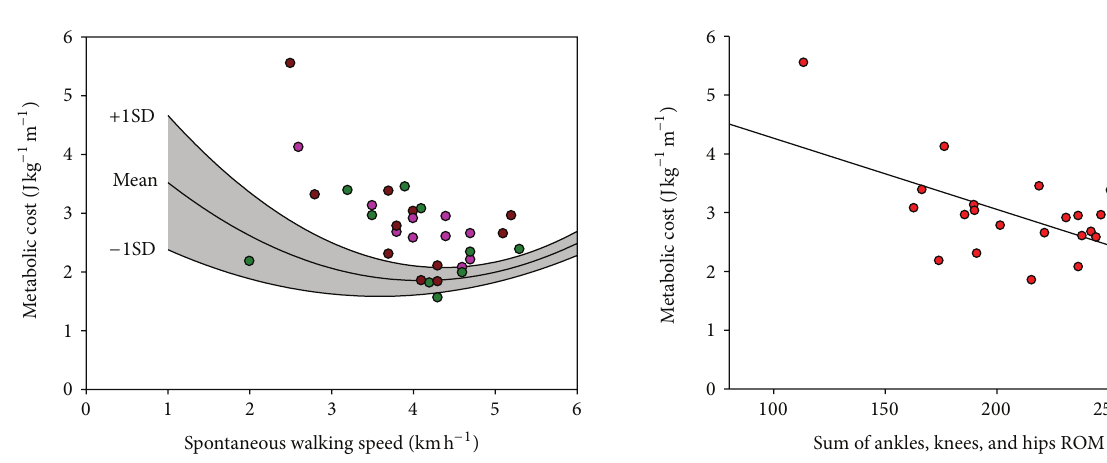
Figure 3: Net metabolic cost in 31 patients with haemophilia as a function of spontaneous walking speed. The severity of joint impairment is arbitrarily classified as “mild” (green symbol, uni/bilateral ankle arthropathy, 𝑛 = 10 ), “moderate” (pink symbol, uni/bilateral ankle arthropathy + unilateral knee arthropathy/total knee replacement, 𝑛 = 10 ), and “severe” (brown symbol, at least bilateral knee arthropathy/total knee replacement, 𝑛 = 11 ).